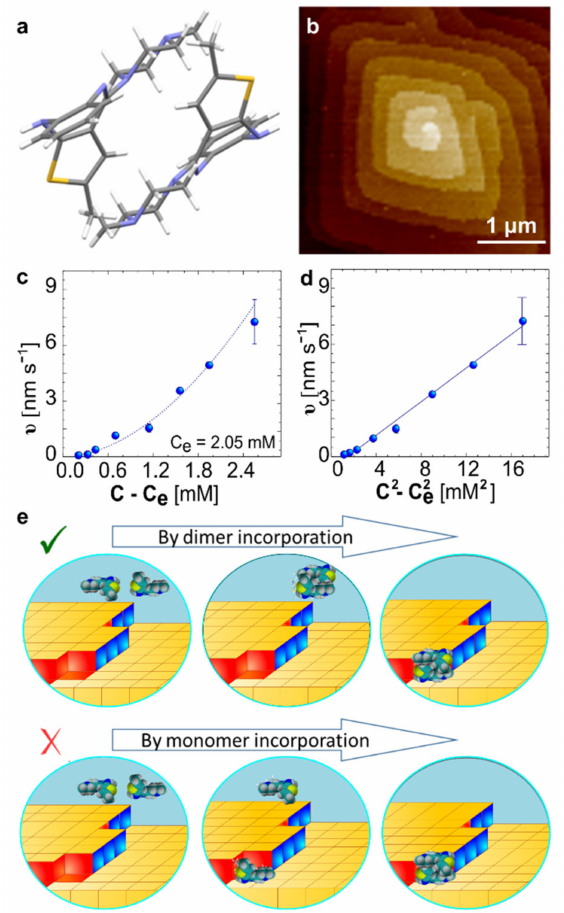
Figure 5. The growth of OZPN crystals. ( a ) The structure of the SC 0 OZPN dimer. ( b ) In situ AFM image of the surface of a (002) face of an OZPN crystal at C = 3.87 mM. New crystal layers are generated by a screw dislocation. ( c ) The velocity ν of steps in the [109] direction as a function of OZPN concentration C in 1/1 ( v / v ) EtOH/H 2 O. ( d ) The linear correlation between ν and ( C 2 − C 2 e ) (cid:0) (cid:1) C 2 − C 2 e has R = 0.95. Dotted lines in (c,d) depict the relation v = β D K D Ω D , where β D is the kinetic coefficient for growth by dimer incorporation, Ω D = 2 Ω M = 0.94 nm 3 is the volume occupied by a dimer in the crystal, and K D is the dimerization equilibrium constant. Error bars in ( c , d ) indicate the standard deviation of v determined as the slope of the displacement-time correlations. ( e ) Schematics of two alternative growth mechanisms. Upper path: two OZPN monomers form a dimer in the solution, which incorporates into the crystal as a whole. Lower path: the two monomers incorporate sequentially, forming a SC 0 dimer in the